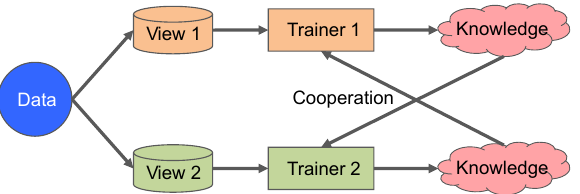
Fig. 2 General procedure of